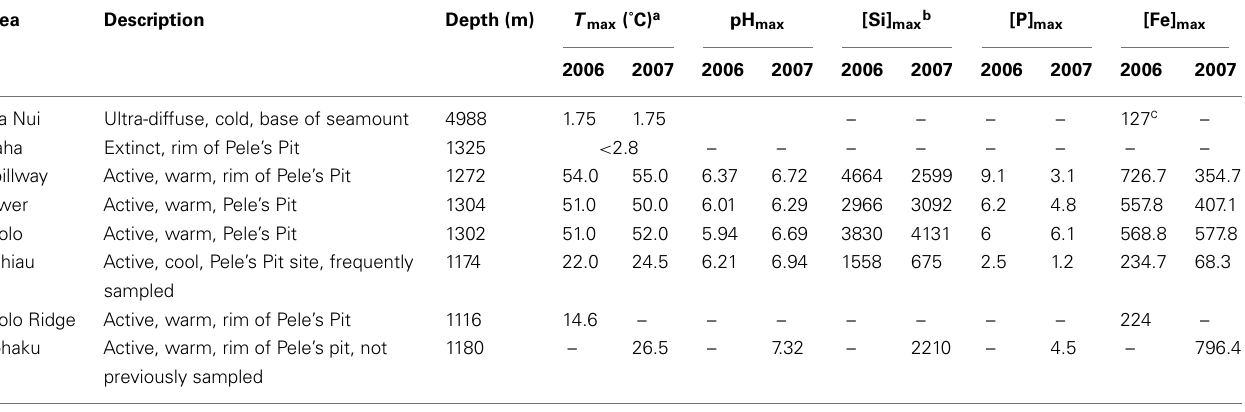
Table 1 | Description of the Loihi Seamount vent areas and vent fluid